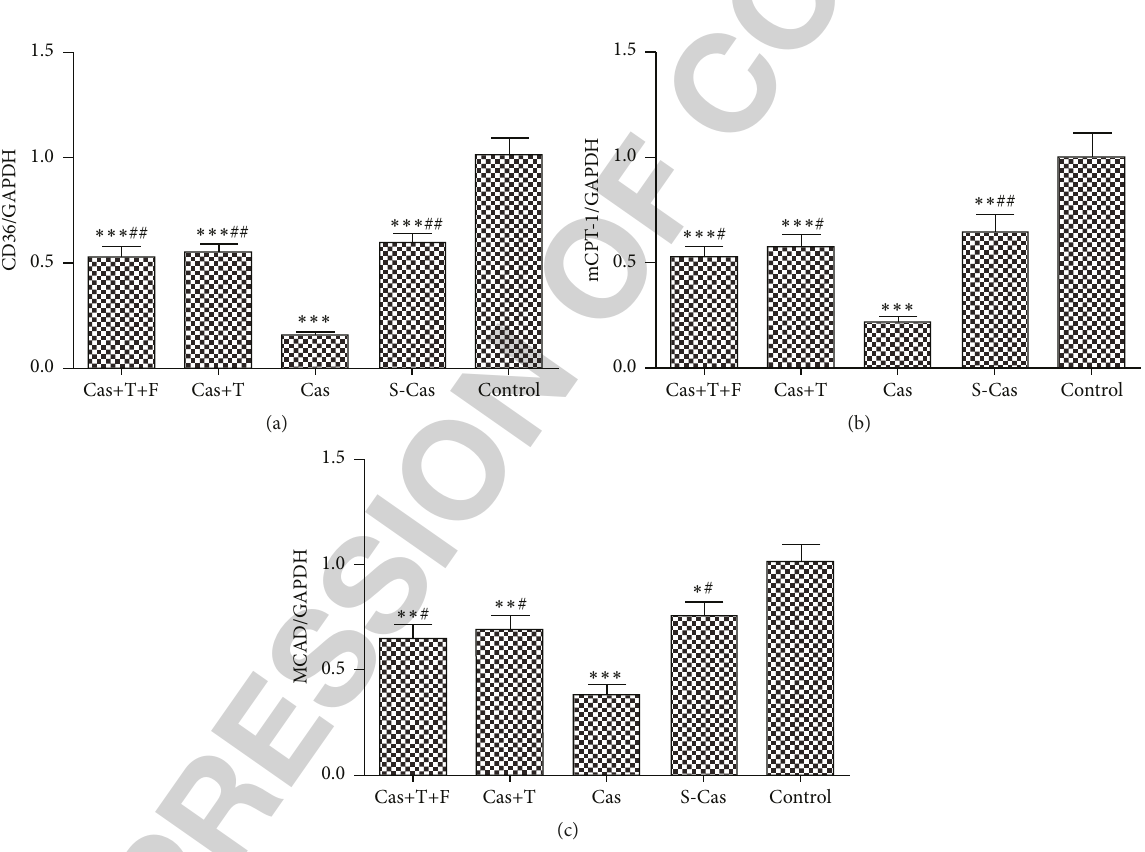
Figure 3: Effects of castration and testosterone replacement on the mRNA expression of fatty acid metabolism. (a–c) mRNA expression levels of CD36, mCPT-1, and MCAD, respectively. Values are means ± SD; 𝑛 = 3 . S-Cas: sham-castration; Cas: castration; T: testosterone; F: flutamide. ∗ 𝑃 < 0.05 , ∗∗ 𝑃 < 0.01 , and ∗∗∗ 𝑃 < 0.001 versus control group; # 𝑃 < 0.01 and ## 𝑃 < 0.001 versus Cas.